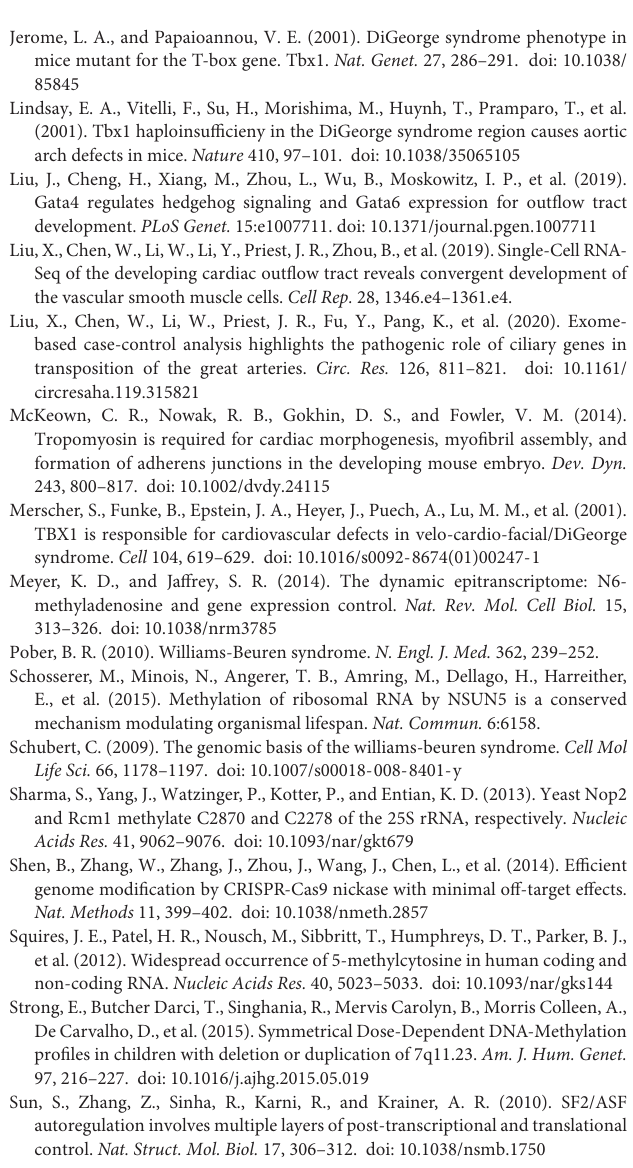
Supplementary Figure 7 | The Nsun5 deletion in MEF cells reduces global m 5 C level. The mRNAs isolated from Nsun5 MEF cells were used in dot blot analyses with m 5 C antibody. n = 3/group. One-way ANOVA test was used for statistical calculation. ∗ P < 0.05, ∗∗ P < 0.01. Supplementary Figure 8 | Western blot assay for Myl2 and Cox4i1 expression. (A) The protein expression of Myl2 confirmed by western blot in E14.5 Nsun5